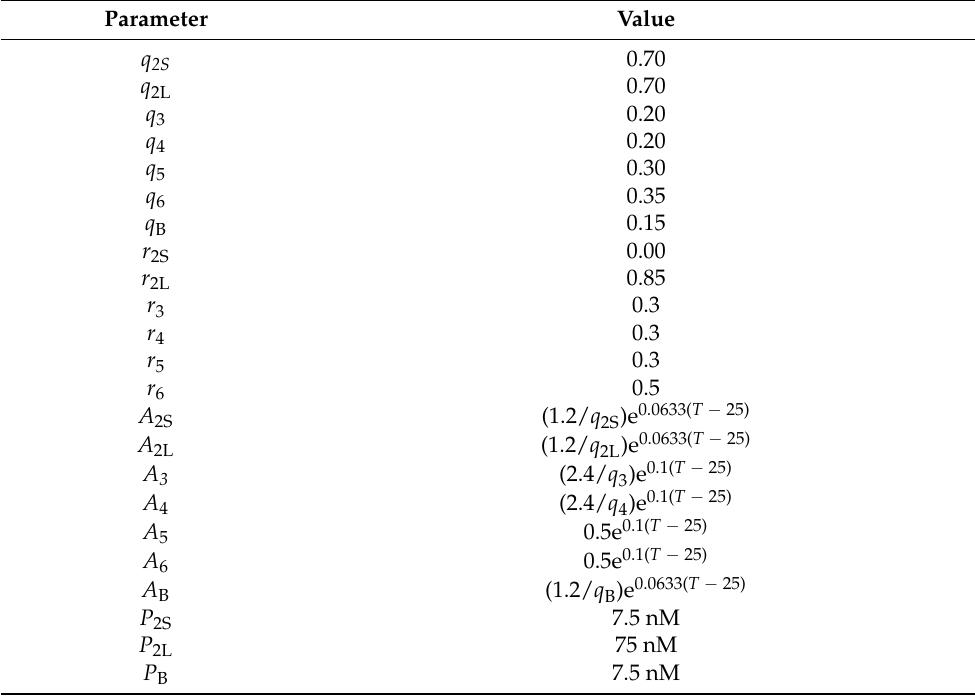
Table 1. Values Assigned to Constant and Temperature-Dependent Parameters in the